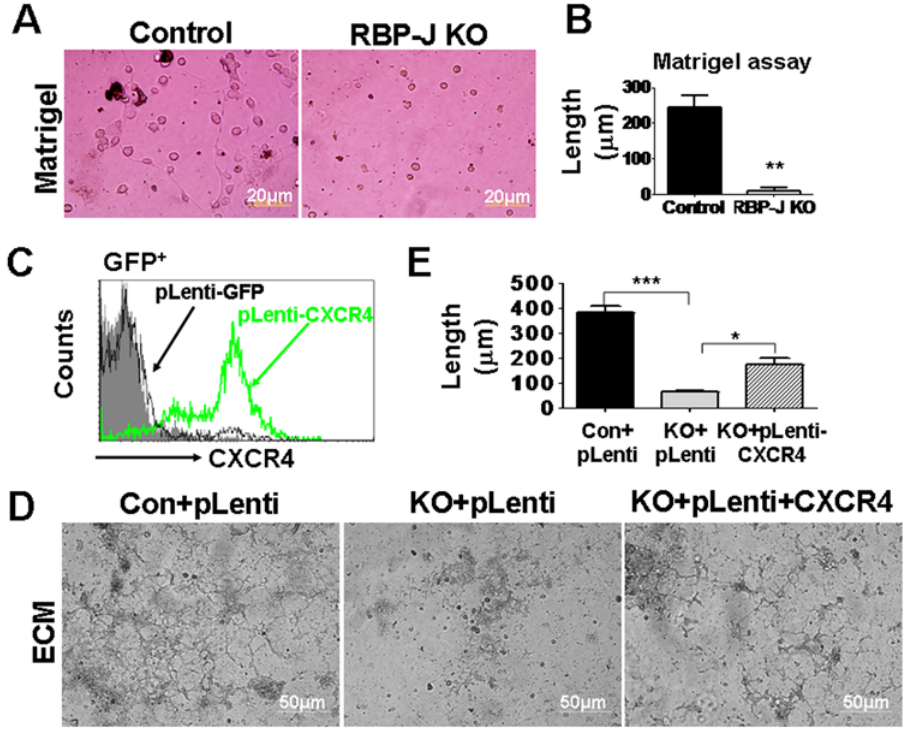
Figure 6. Over-expression of CXCR4 rescued the defects in vessel formation of the RBP-J deficient EPC. ( A ) Vessel formation by the cultured EPC with different genotypes in matrigel. ( B ) The quantitative analysis of vessel length in ( A ) (bars=mean 6 SD; n=4; ** P , 0.01). ( C ) The overexpression of the mouse CXCR4 by Lentivirus infection. HeLa cells were infected with different virons and the CXCR4 expression was assessed by FACS. ( D ) EPC with different genotypes were transduced with the Lentivirus vector or the Lentivirus expressing CXCR4, and were assayed for the vessel formation capability in the ECM culture system. ( E ) The quantification of the vessel length in ( D ) (bars=mean 6 SD; n=4; * P , 0.05; *** P , 0.001).